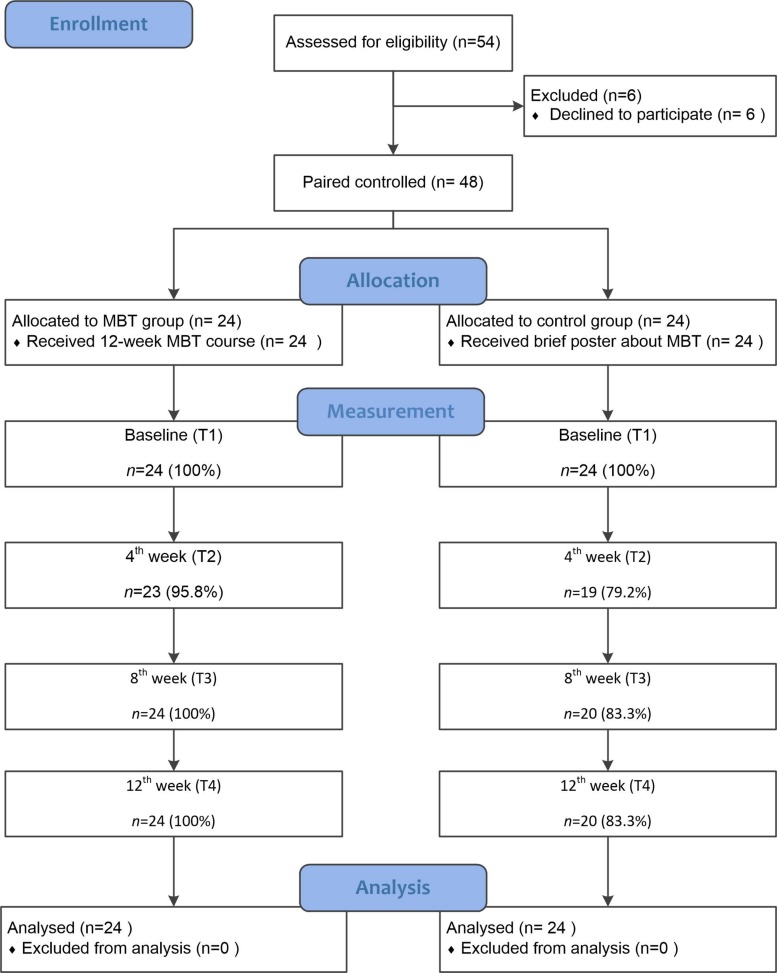
Research procedures.